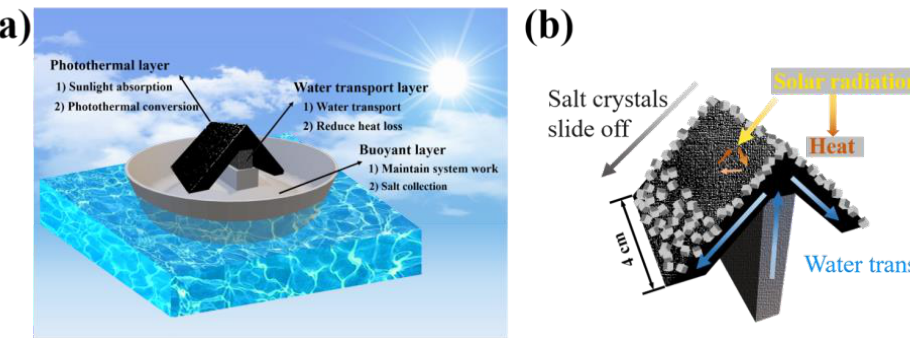
Figure 5. ( a , b ) schematic illustration of crystallizer based on 3D